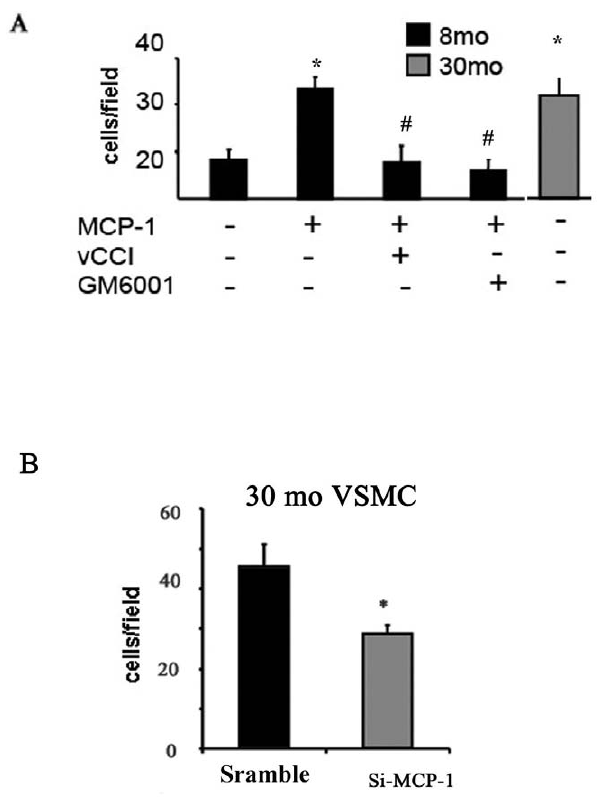
Figure 5. VSMC Invasion. A. VSMC treated with or without MCP-1 (50 ng/ml) plus vCCi (150 ng/ml) or GM 6001 (15 m M). *p , 0.05, vs. young; # p , 0.05, vs MCP-1 treatment alone. B. Old VSMC with or without si-MCP-1 (50 nM). *p , 0.05 si-MCP-1 vs. scramble control.